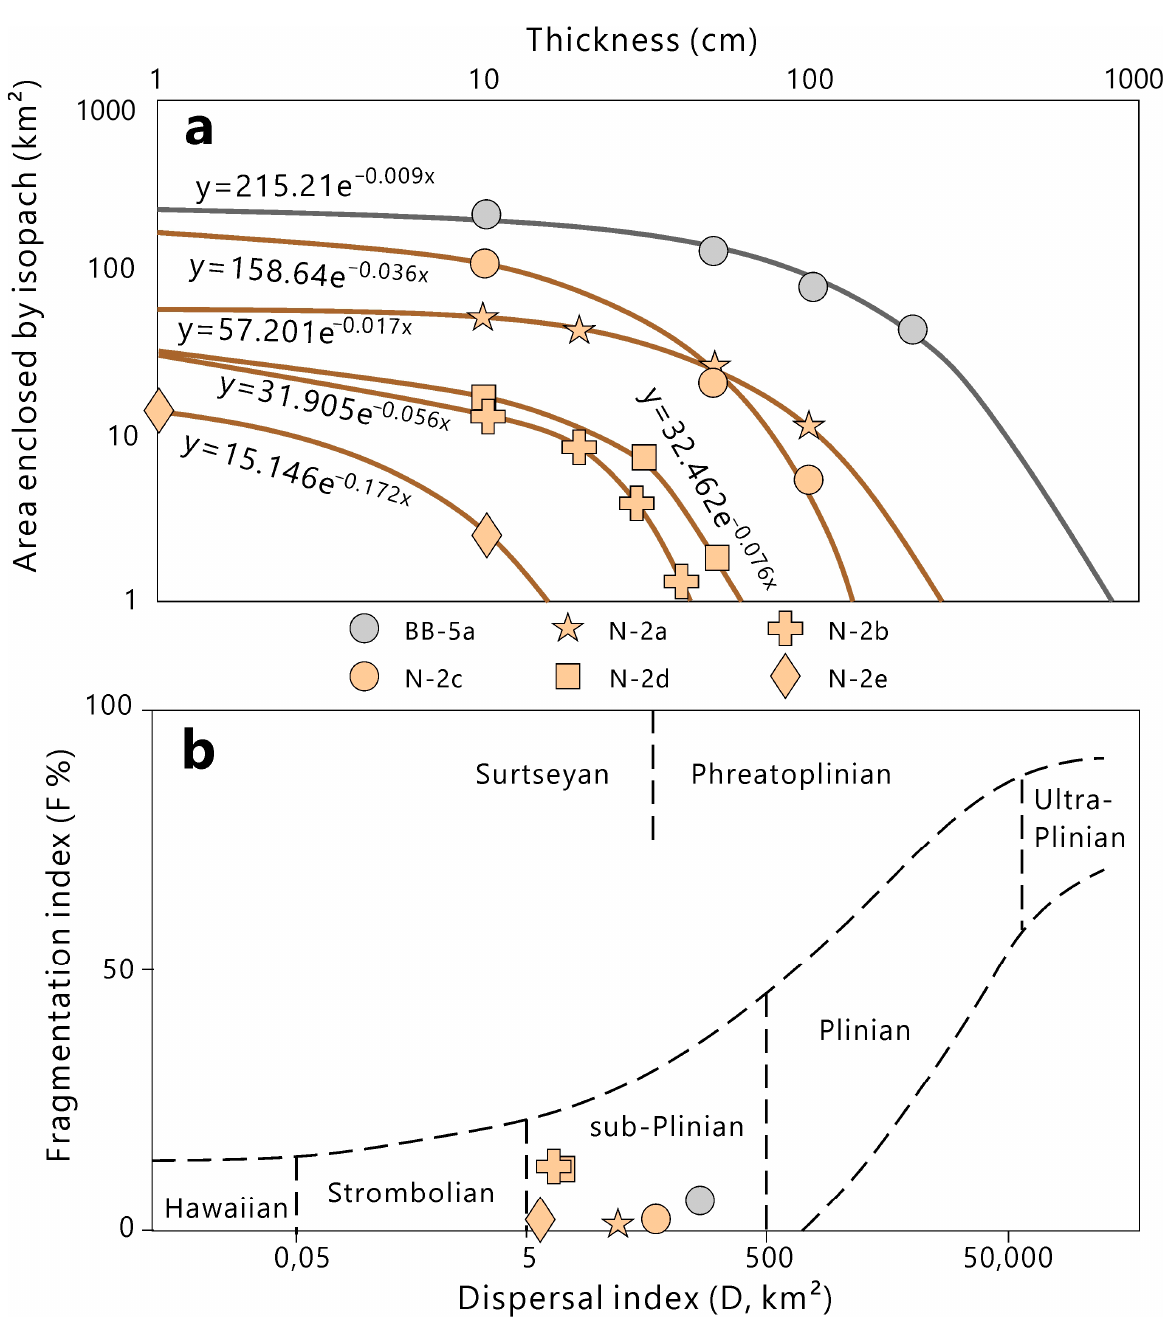
Figure 10. ( a ) Correlation between area enclosed by isopach and deposit thickness. Circles corre- spond to data obtained from fieldwork. The area enclosed by a 1 cm isopach is estimated from the extrapolation of field data. ( b ) Classification of the eruption style (Walker 1973) on the basis of the fragmentation index (F, %) and dispersal index (km 2 ). All pyroclastic fall deposits from Banda Besar and Naira (shown as light grey and light brown color) are categorized as sub-Plinian.